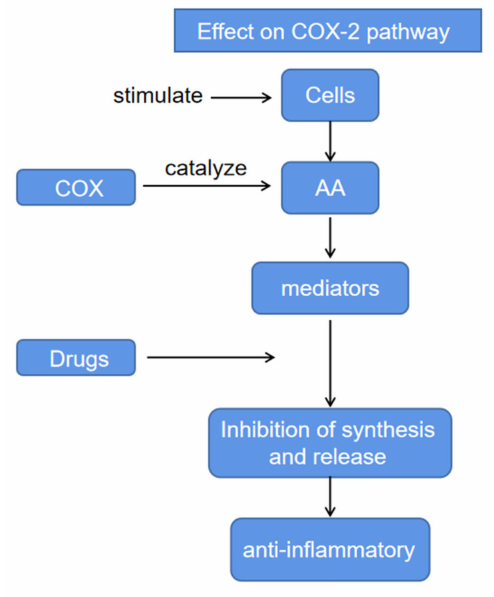
Figure 3. Effect on Cyclooxygenase-2